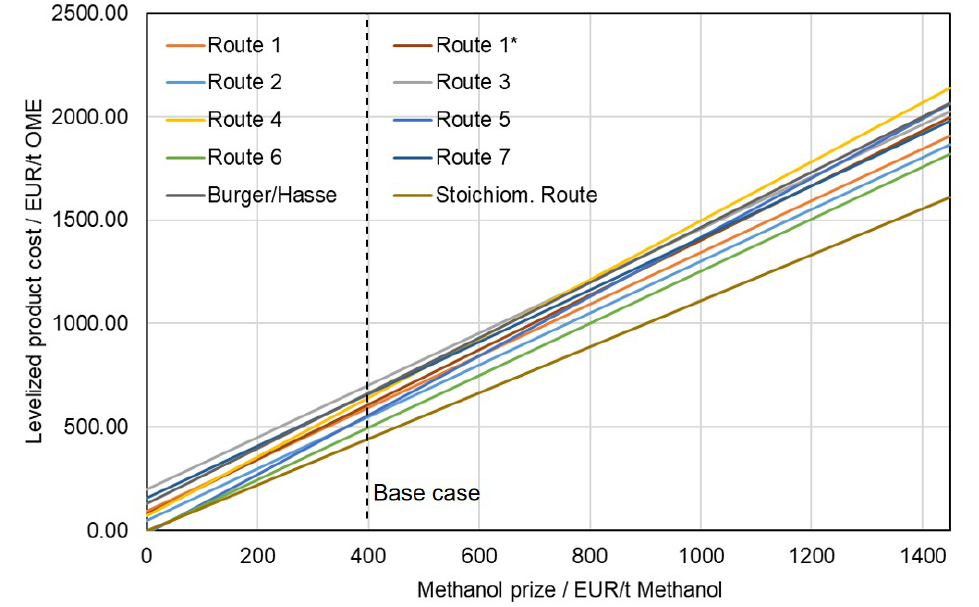
Figure 5. Levelized product cost per t OME for all routes as a function of the methanol cost for a plant size of 100